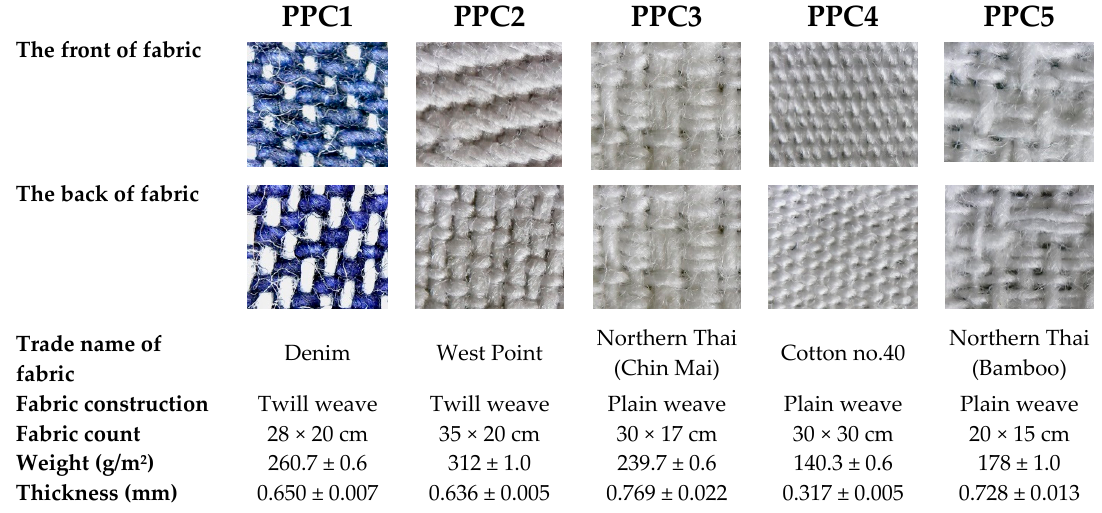
Figure 1. Properties of fabrics which were used to tailored personal protective clothing (PPC).